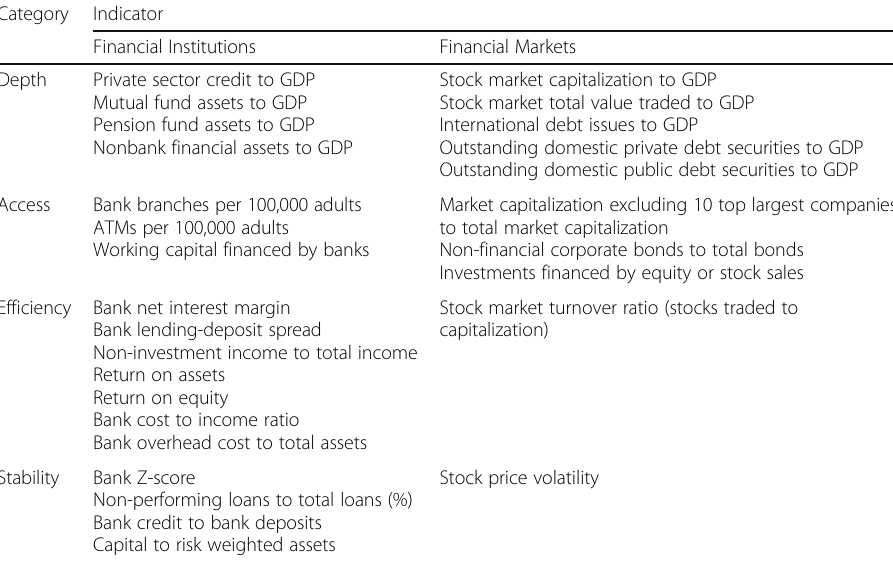
Table 2 Variables used for construction of financial development index Category